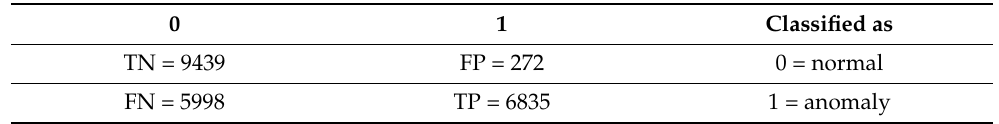
Table 7. Measurement of K-mean parameters.